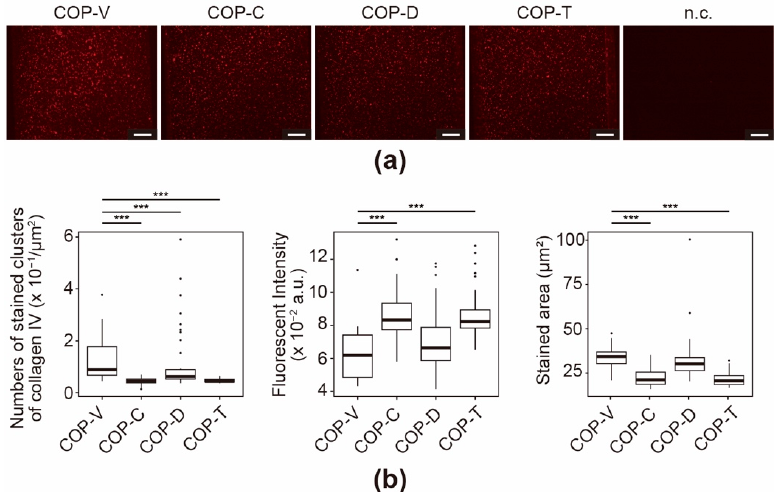
Figure 5. Immunofluorescence for collagen IV (Col IV) in Matrigel-coated cyclo-olefin polymer (COP) microfluidic channels. ( a ) Micrographs of immunostained Col IV in Matrigel-coated COP microfluidic channels processed using vacuum ultraviolet (VUV) photobonding (COP-V) or solvent bonding with cyclohexane (COP-C), toluene (COP-T), or dichloromethane (COP-D). n.c. represents the negative control of a COP-V microfluidic channel coated with Matrigel and stained with a secondary antibody. Scale bars: 100 µ m. ( b ) Quantitative analyses of the immunostained Col IV in the Matrigel-coated COP microfluidic channels. The center lines indicate the median values; the box limits indicate the 25th and 75th percentiles; the whiskers extend to 1.5-times the interquartile range from the 25th and 75th percentiles; and outliers are represented by dots. Each experiment was repeated four times, and more than ten images of the COP devices from each experiment were used for